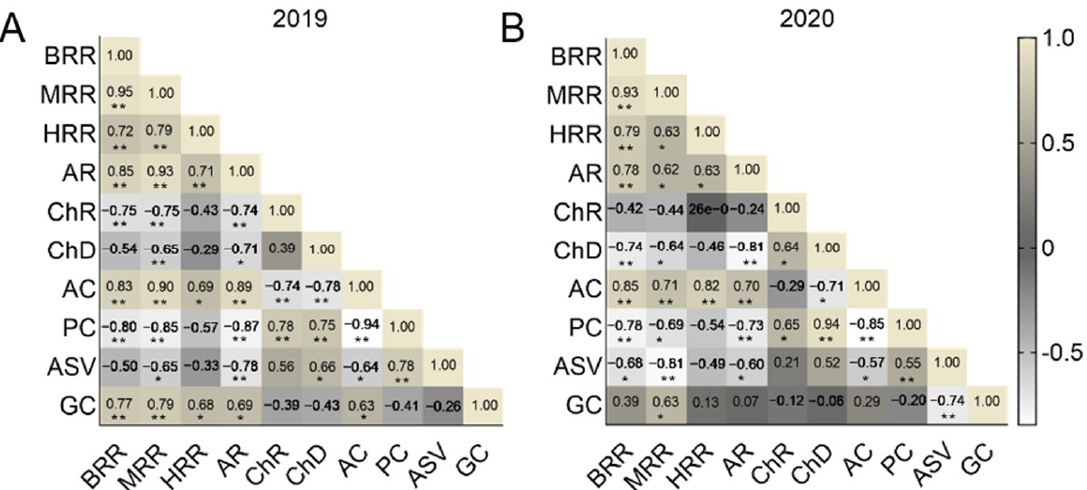
Figure 5. Pearson’s correlation analysis of the correlation of quality indicators of O8 and WT under different fertilizer treatments. Correlation analysis of different fertiliser treatments on the quality of O8 and WT in 2019 ( A ) and 2020 ( B ). BRR: Brown Rice Rate, MRR: Milling Rice Rate, HRR: Head milling Rice Rate, AR: Aspect ratio, ChR: Chalky Rice Rate, ChD: Chalkiness Degree, AC: Amylose Content, PC: Protein Content, ASV: Alkali Spreading Value, GC: Gel Consistency. ** Significant at p < 0.01. * Significant at p < 0.05.